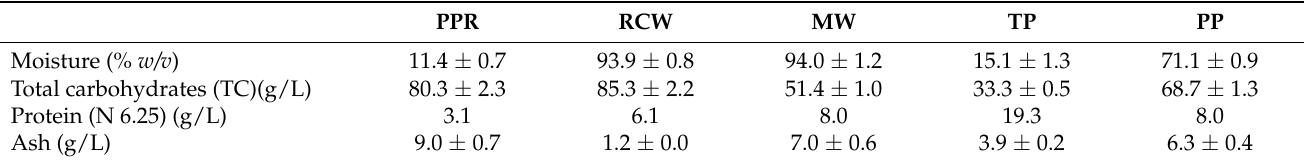
Table 3. Chemical composition of the residues and waste used in this